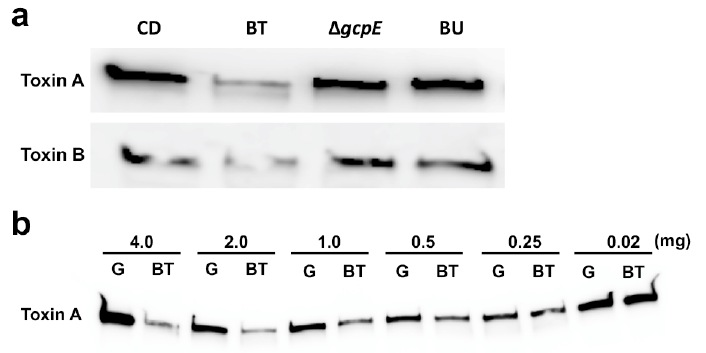
Figure 3. Characterization of the ∆ gcpE mutant strain. ( a ) The Tn 4351 insertion site in the ∆ gcpE mutant. Tn 4351 was inserted into the 5 ′ end of gcpE . *Stop codon of the upstream gene (BT2518). ( b ) Gram stain of wild type BT and ∆ gcpE strains. ( c ) Mucoid layer in BT culture following centrifugation of either BT WT or ∆ gcpE . ( d ) Toxin A levels in CD culture alone, exposed to the supernatant of wildtype BT or ∆ gcpE .